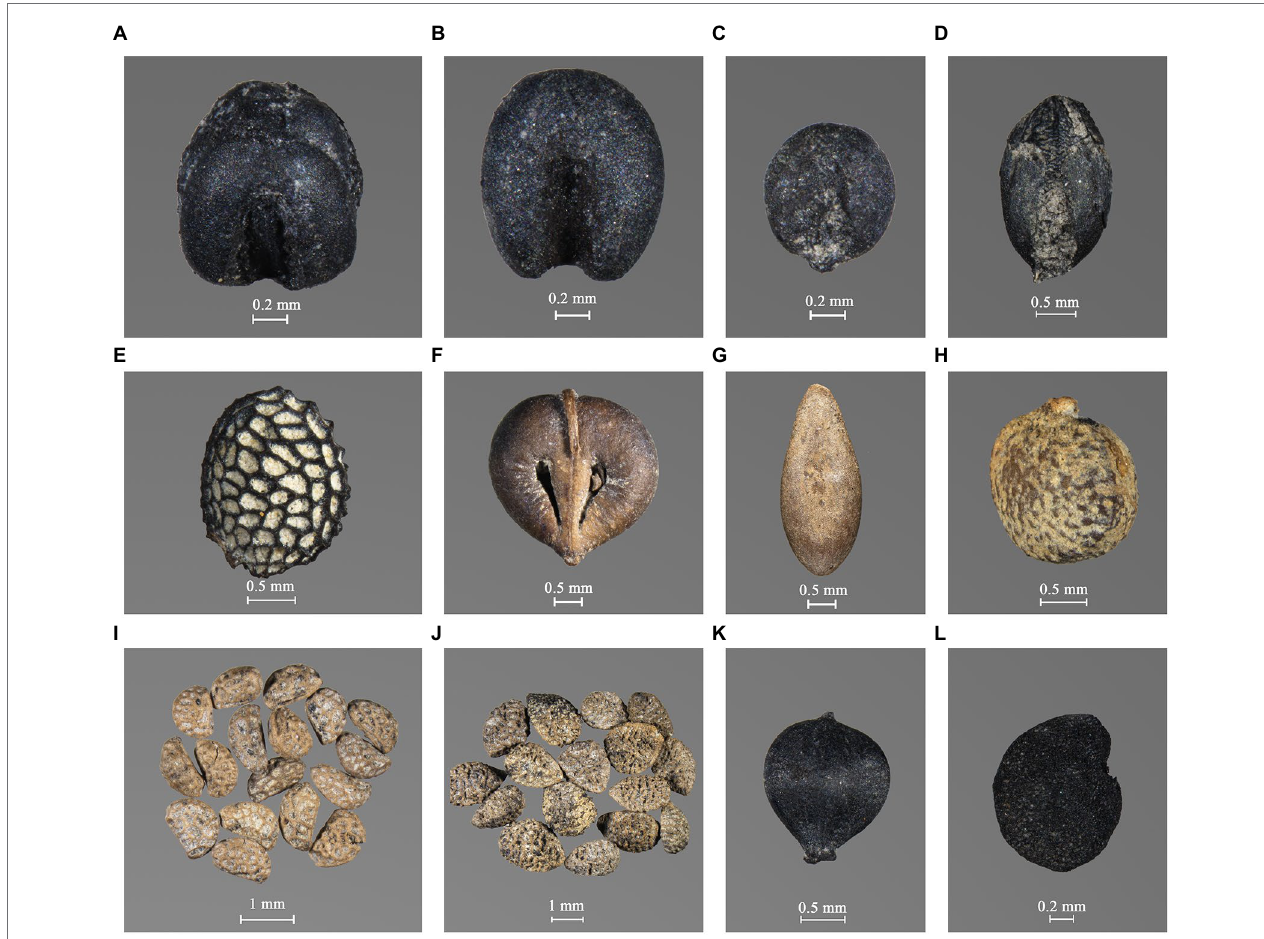
FIGURE 6 | Other main plant remains from the Zhiwuyuan site. (A) Mature foxtail millet grain, (B) immature foxtail millet grain, (C) very immature foxtail millet grain, (D) Setaria sp., (E) Actinidia sp., (F) Vitis sp., (G) Cucumis sp., (H) Broussonetia papyrifera , (I) Rubus sp., (J) Sambucus sp., (K) Scirpus sp., and (L)